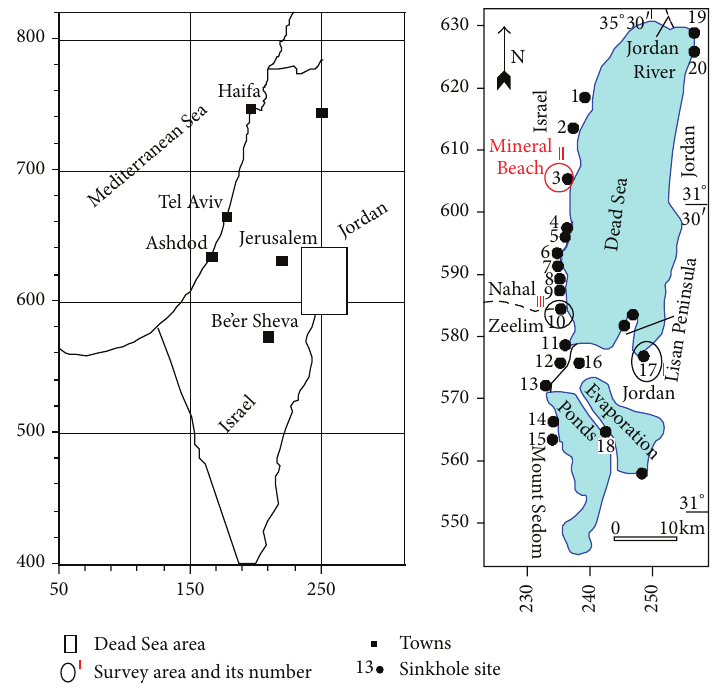
Figure 1: Sinkhole sites along the Dead Sea shore: (1) Palms, (2) Samar Spring, (3) Mineral Beach, (4) Ein Gedi and Nahal Arugot, (5) Yesha, (6) Zeruya, (7) Nahal Hever northern, (8) Nahal Hever southern, (9) Asa’el, (10) Nahal Zeelim, (11) Mezada, (12) Rahaf, (13) Mor, (14) Ein Boqeq, (15) Newe Zohar, (16) Lisan Peninsula, (17) Ghor Al-Haditha, (18) Dam-2. I–III: sites under investigation. (coordinates are in km, new Israel Mercator grid).